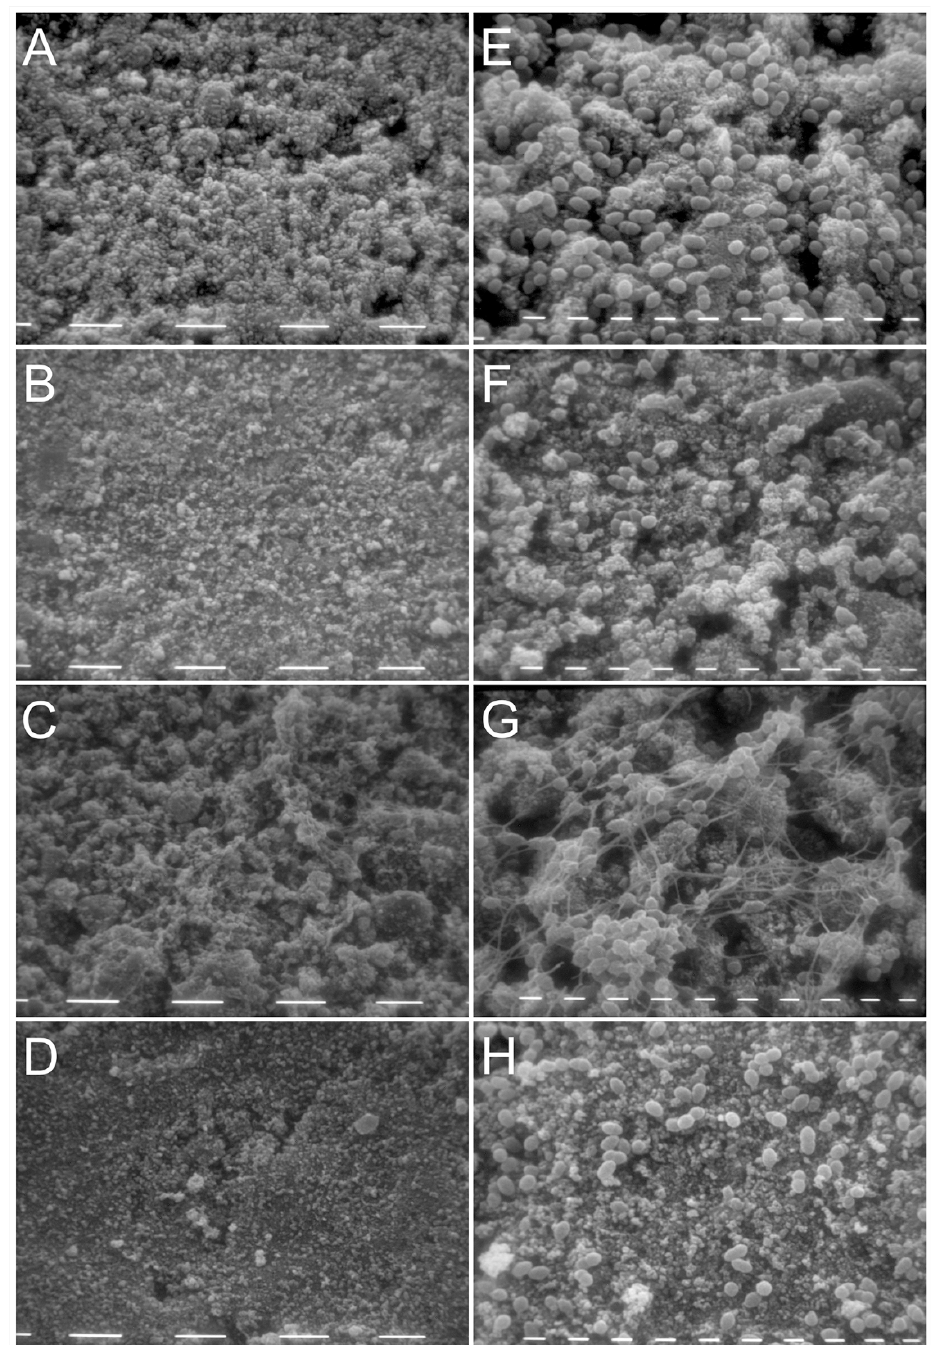
Figure 4. Representative scanning electron microscopy (SEM) images of E. faecalis biofilms on HA disks. Images of 48 h-old E. faecalis ATCC 29212 biofilms were acquired by SEM after exposure to H 2 O (control; A and E ), Ca(OH) 2 -saturated solution ( B and F ), KP (100 µg/mL; C and G ), and L18R (50 µg/mL; D and H ) for 24 h. Magnification 1250× ( A – D , bar = 10 µm) and 5000× ( E – H , bar = 1 µm).